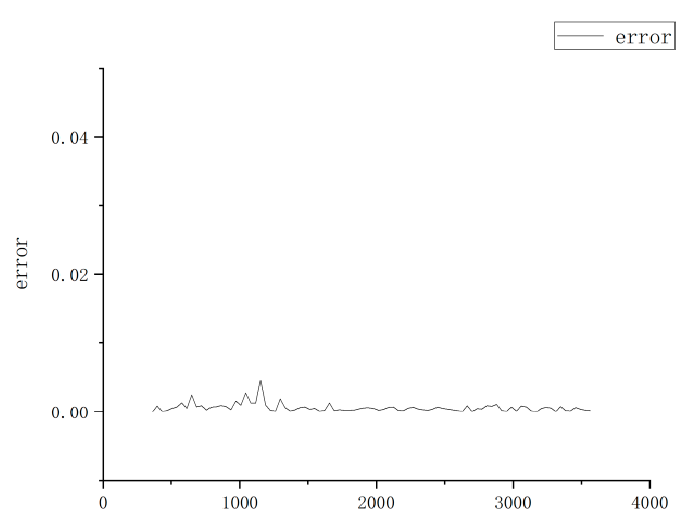
Figure 18. Comparison of the actual and predicted values.